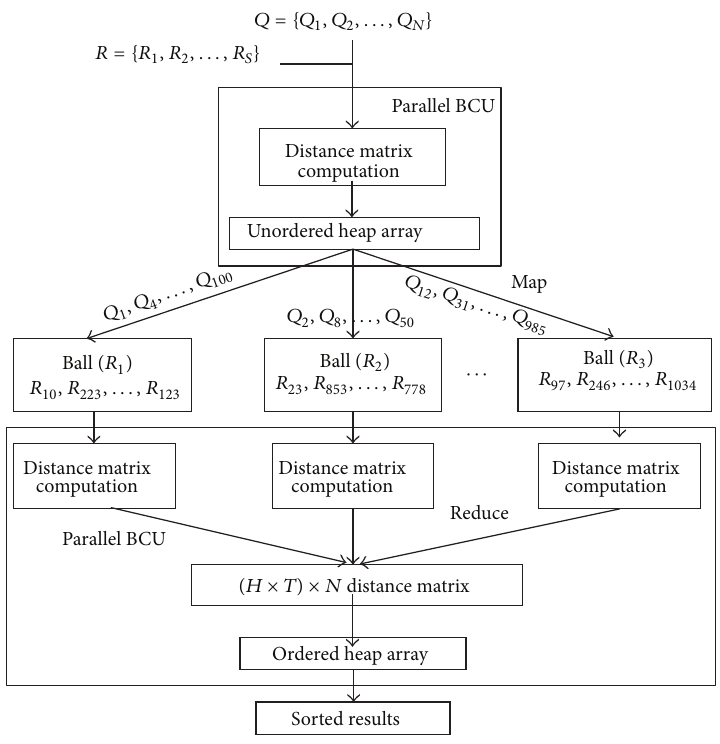
Figure 5: Parallel online retrieval in